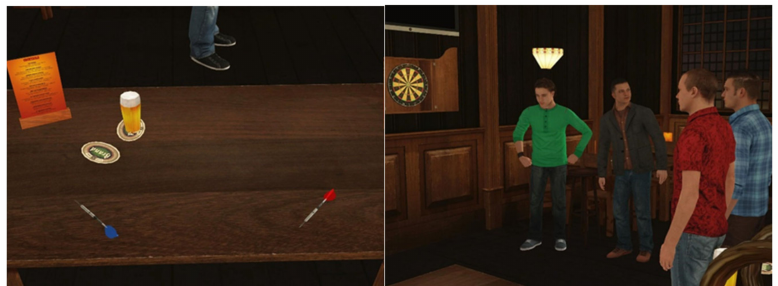
Figure 4. The VR pub scenery. Left : The table where the participant was sitting behind. Right : Dartboard, two players (read and blue shirts), and two spectators.